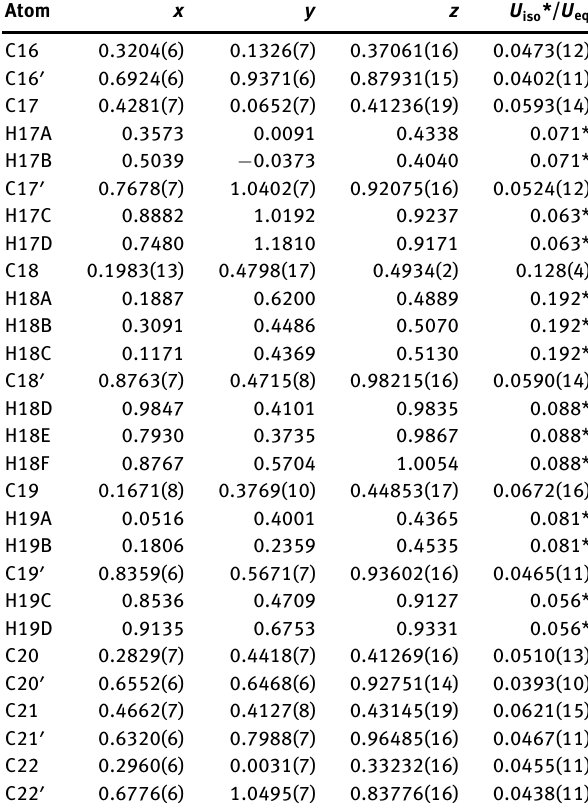
Table 2: Fractional atomic coordinates and isotropic or equivalent isotropic displacement parameters (Å 2